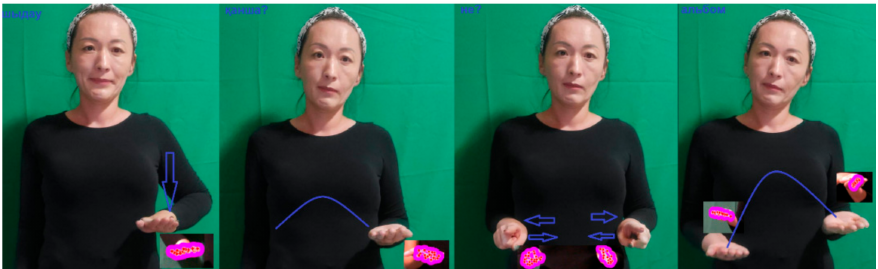
Figure 6. An example of gestures in which it is difficult to recognize the orientation of the